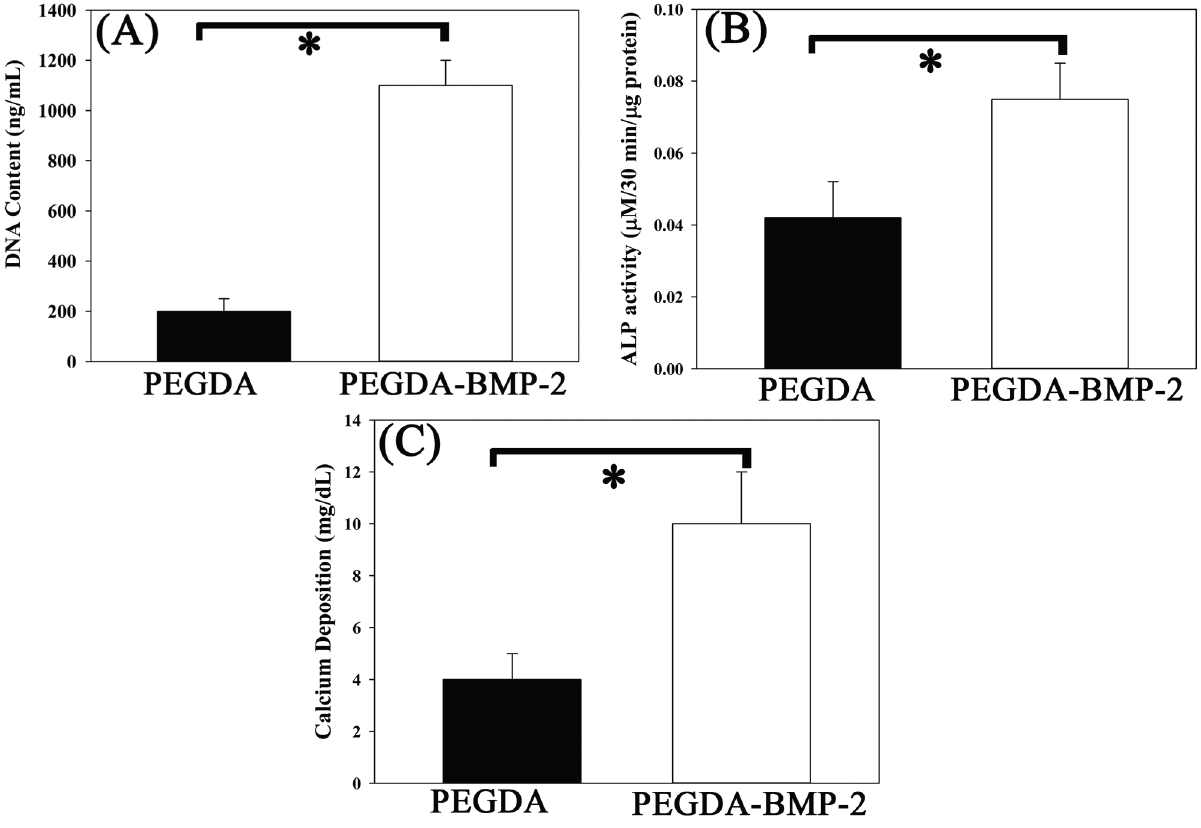
Figure 8. Quantitative analyses of cell proliferation ( A ); alkaline phosphates secretion ( B ) and calcium deposition ( C ) of LFs cultivated in PEGDA and PEGDA-BMP-2 photo-responsive hydrogels after 12-week transplantation. Triplicates were used for each experiment. * p <